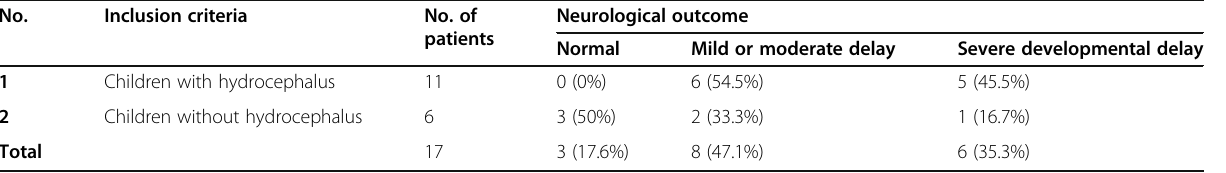
Table 2 The neurological outcome in relation to the presence of hydrocephalus